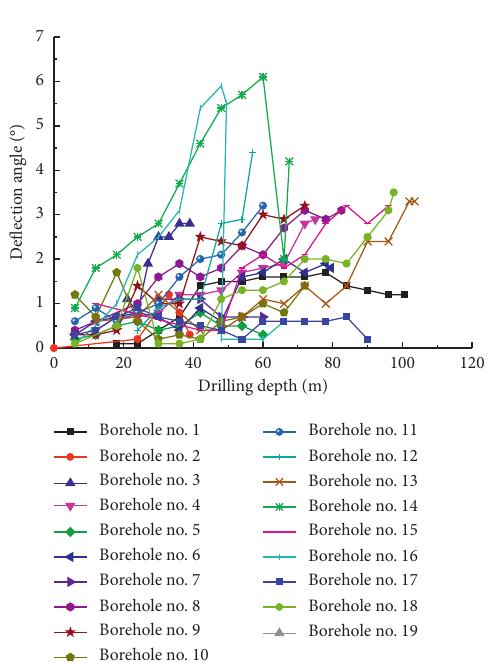
Figure 7: Change in the dip angle when the angle of encountered layer is greater than the critical value.